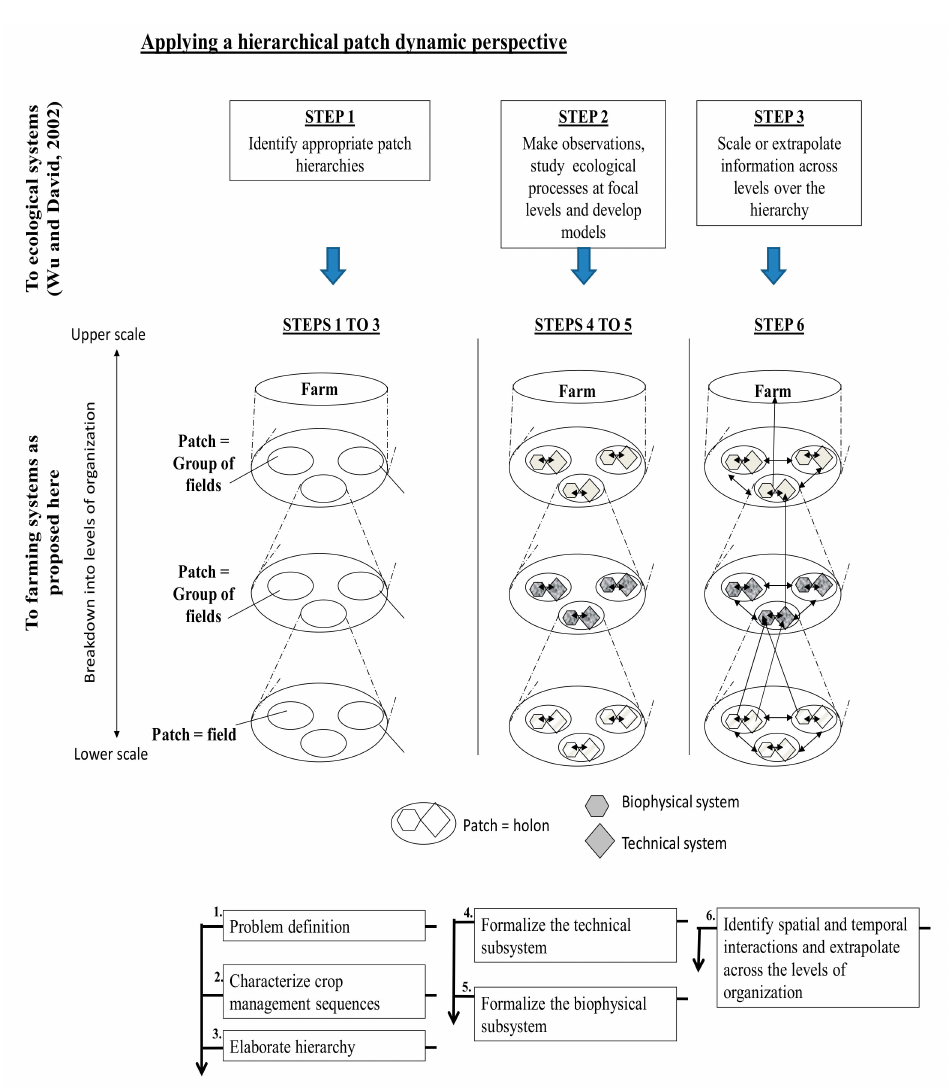
Figure 1. Hierarchical patch dynamics theory in farming systems derived from ecological systems [11]: framework of analysis and six-step procedure to break the farming system down into a patch